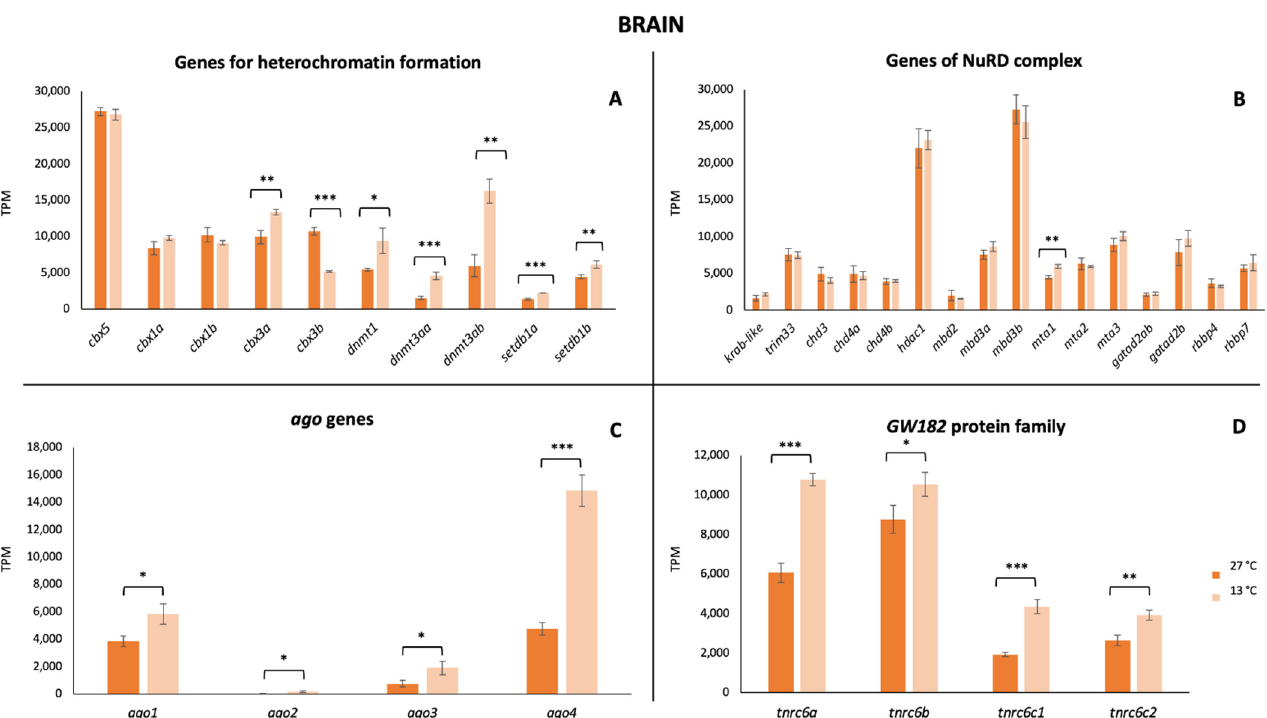
Figure 2. Expression of genes involved in TE silencing mechanisms in brain. ( A ) Expression values of genes encoding for proteins involved in heterochromatin formation. ( B ) Expression values of genes encoding for proteins forming the NuRD complex. ( C ) Expression values of members of the gene subfamily Argonaute . ( D ) Expression values of genes belonging to the GW182 family proteins. Values are reported for both tested temperature conditions (27 °C and 13 °C). Statistically significant differences are presented as * for p < 0.05, ** for p < 0.01, and *** for p < 0.001.